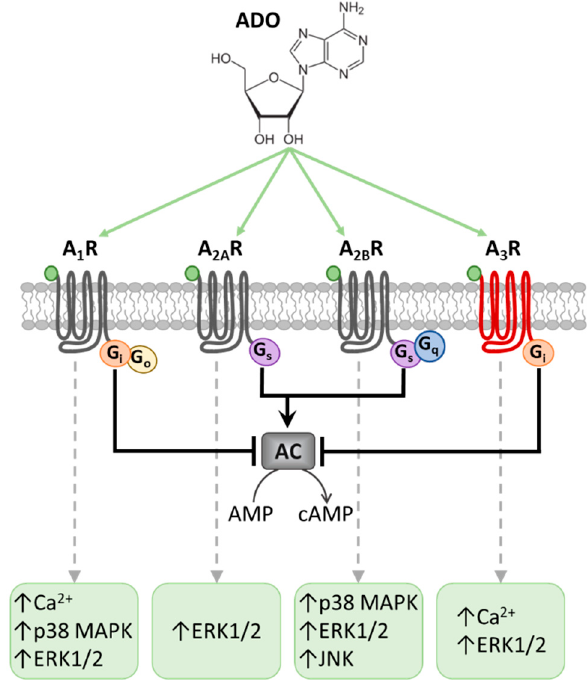
Figure 1. Adenosine receptors and the main transduction pathways involved in their activation. Schematic representation of G protein-coupled A 1 , A 2A , A 2B and A 3 receptor (A 1 R, A 2A R, A 2B R and A 3 R) subtypes activated by extracellular adenosine (ADO), and the main intracellular pathways involved. A 2A Rs and A 2B Rs are coupled to the Gs protein, which leads to adenylyl cyclase (AC) activation and cyclic AMP (cAMP) increase. On the other hand, A 1 R and A 3 R are coupled to the G i protein that inhibits AC and reduces cAMP. In some districts, A 2B Rs are also coupled with G q proteins and A 1 R with Go, which stimulate Ca 2+ release from intracellular stores. All adenosine receptors are coupled to mitogen-activated protein kinase (MAPK) pathways, including extracellular signal-regulated kinase 1/2 (ERK1/2), p38 MAPK and Jc-Jun-NH2 terminal Kinase (JNK).